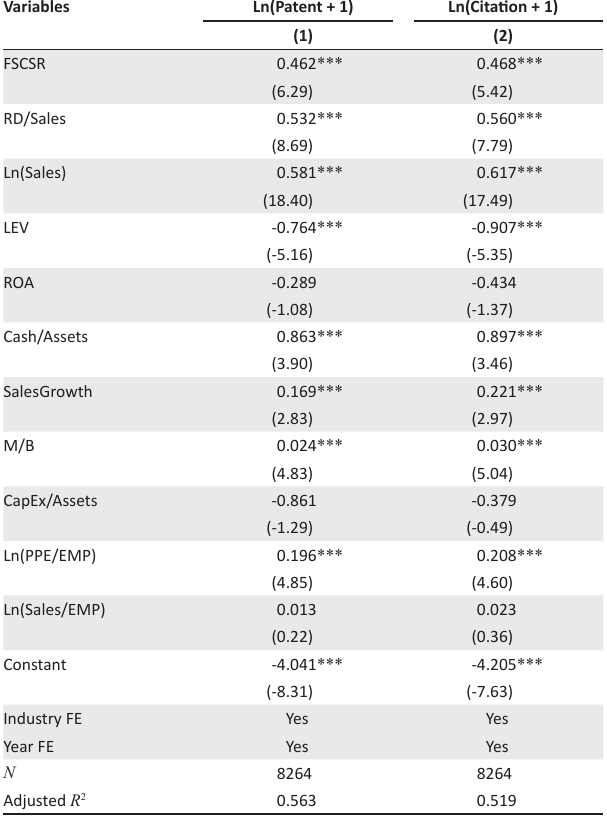
TABLE 4: Focused strategic corporate social responsibility and corporate innovation. Variables Ln(Patent +